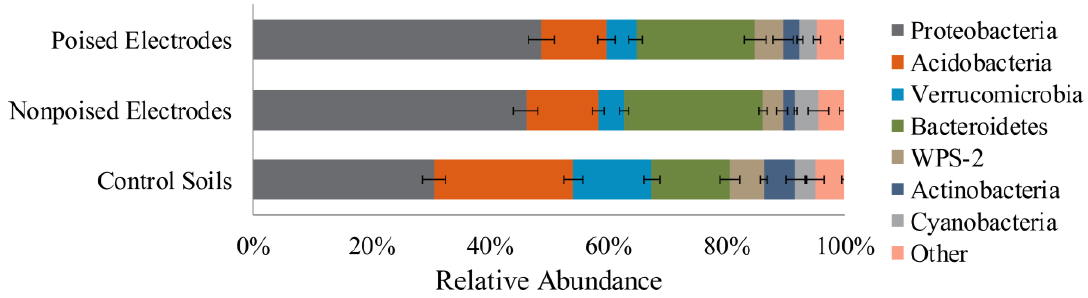
Figure 3. Relative abundance of the seven most prevalent bacterial phyla from shallow soil and biofilm samples at the end of a five-week experimental period. Proteobacteria, acidobacteria, verrucomicrobia, and bacteroidetes accounted for >80% of the microbial communities in all three sample types. Error bars indicate standard error, calculated from taxonomic composition of all samples from a given type ( i.e. , soils, nonpoised electrodes, poised